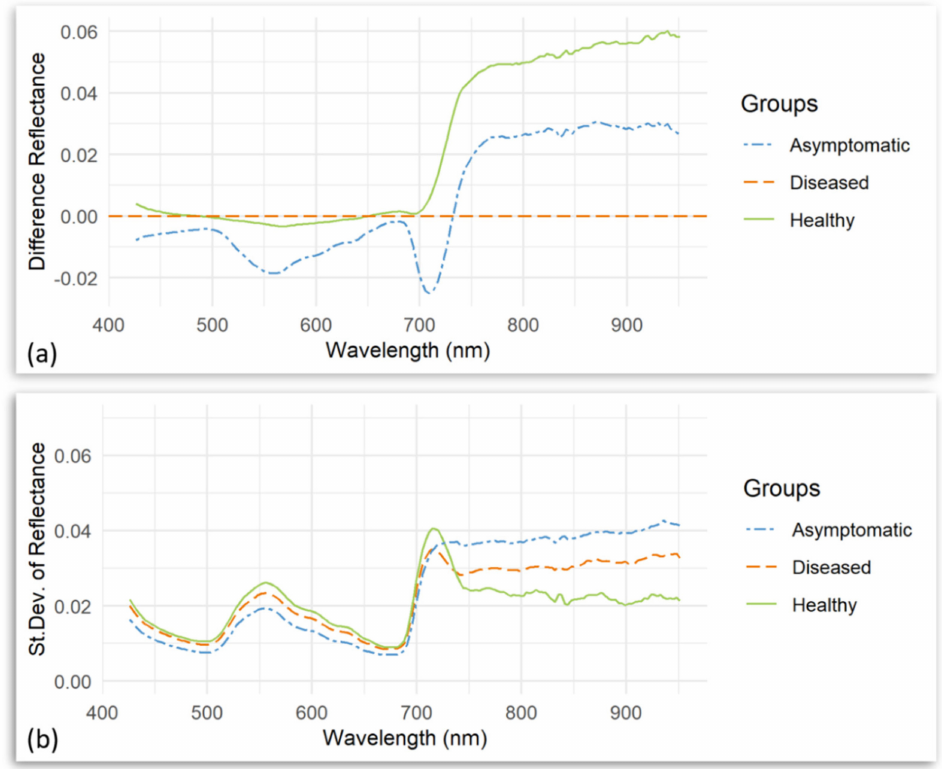
Figure 8. Panel ( a ) shows mean reflectance of healthy minus diseased plants and asymptomatic minus diseased plants; panel ( b ) shows the standard deviations within each group of